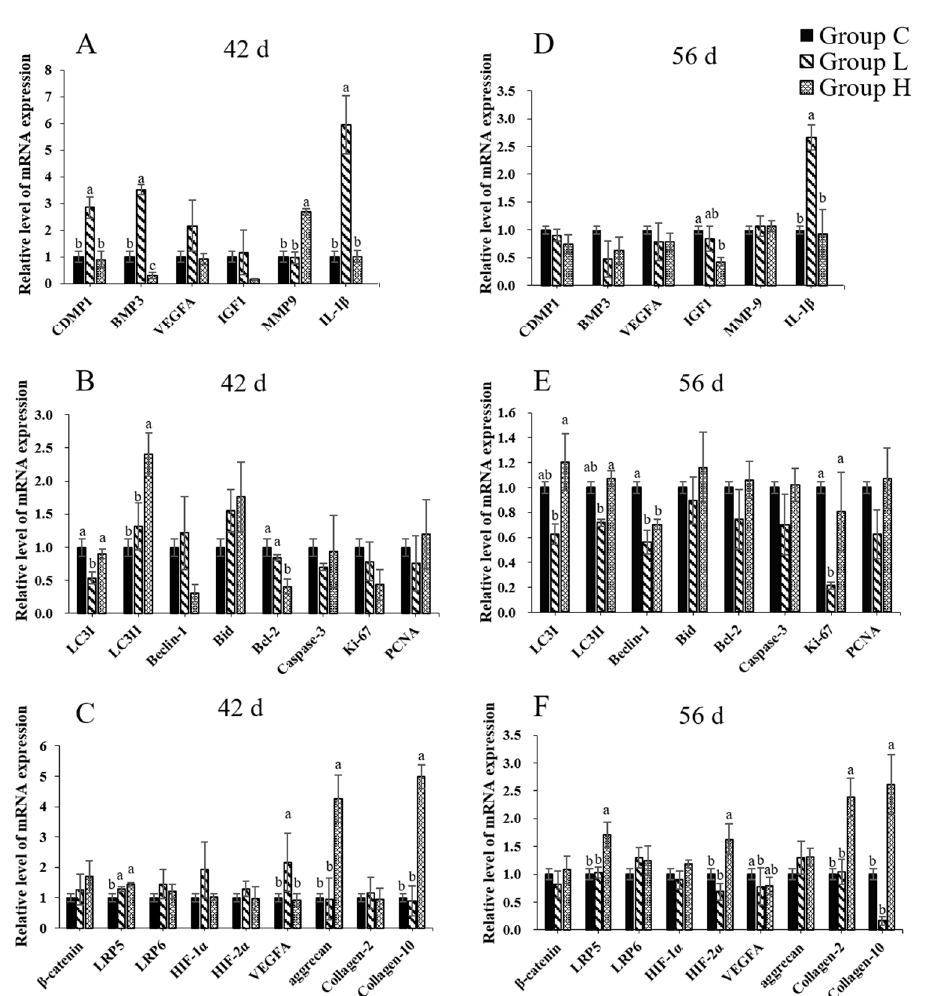
Figure 5. The mRNA expression of chondrocytes in three groups. ( A ) The 42-d expression of ECM-homeostasis relative genes. ( B ) The 42-d expression of cell-homeostasis relative genes. ( C ) The 42-d expression of the WNT signal pathway and hypoxia-inducible factors (HIFs). ( D ) The 56-d expression of ECM-homeostasis relative genes. ( E ) The 56-d expression of cell-homeostasis relative genes. ( F ) The 56-d expression of the WNT signal pathway and HIFs. Superscripts with different letters indicate significant differences ( p < 0.05).